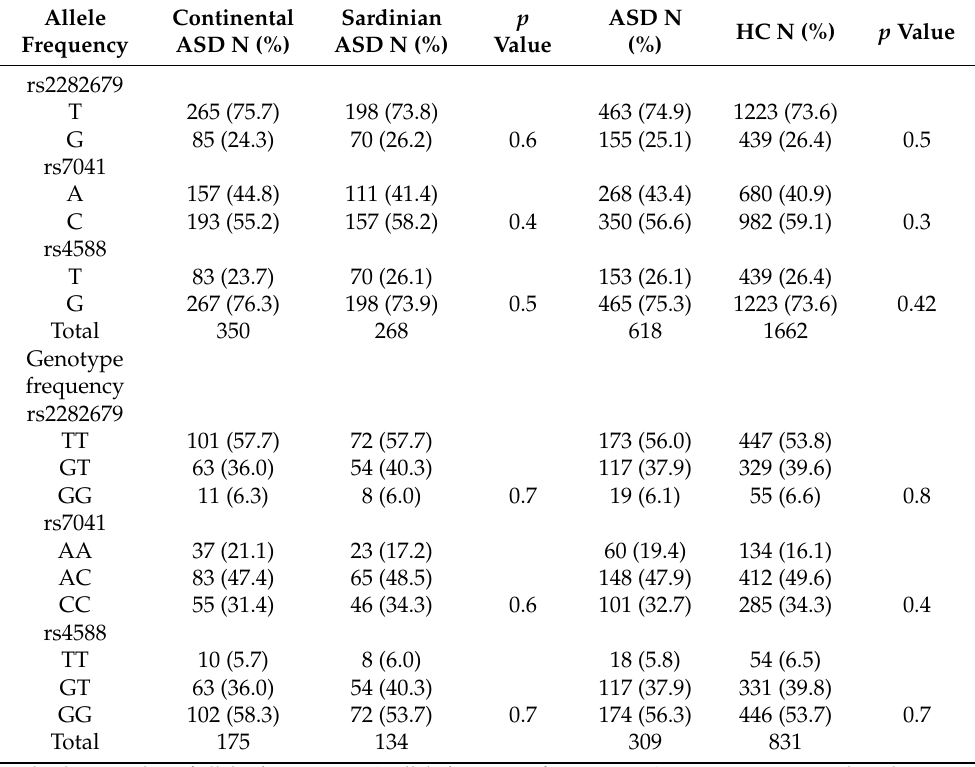
Table 1. Allele and genotype distributions of rs2282679, rs7041, and rs4588 SNPs in ASD children and healthy controls